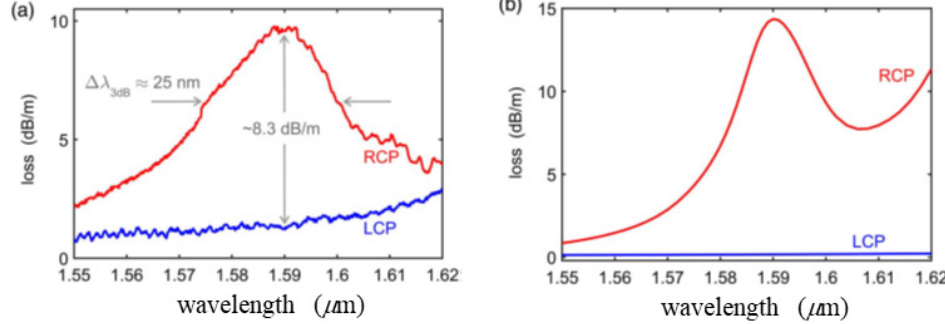
Figure 22. ( a ) Measured and ( b ) numerically modeled modal loss of the RCP and LCP core modes as a function of wavelength for the twisted SRPCF. Adapted with permission from Ref. [84] © The Optical Society.